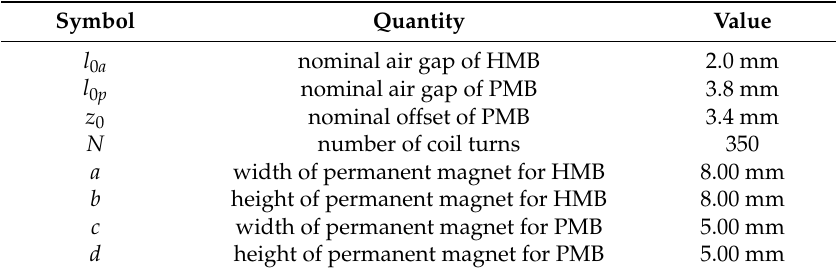
Table 2. Parameters of HMB and PMB.